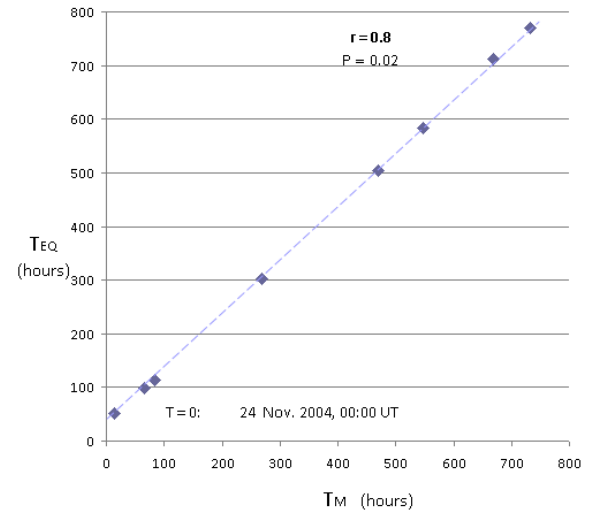
Fig. 6. The time of the earthquake occurrence T EQ versus the time of the last maximum K p value T M before the corresponding EQ (see in the text). A strong correlation ( r = 0.8) was found between the eight pairs of the values T EQ and T M considered.